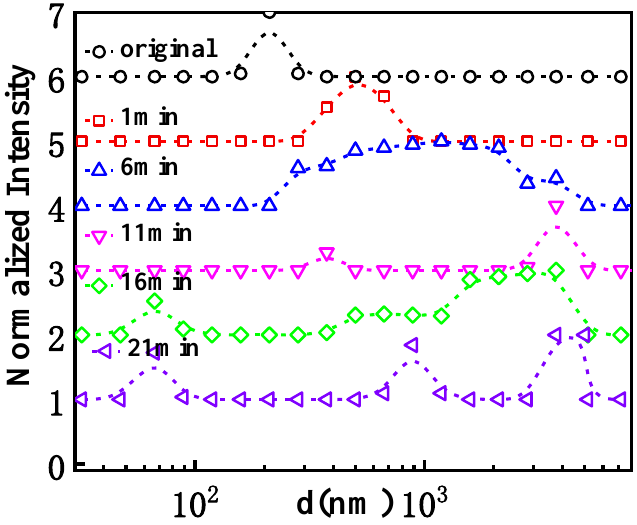
Figure 2. Size distribution of 3 mg/mL GPAM1 solutions with 0.01 M HAc at different times at 40 °C.